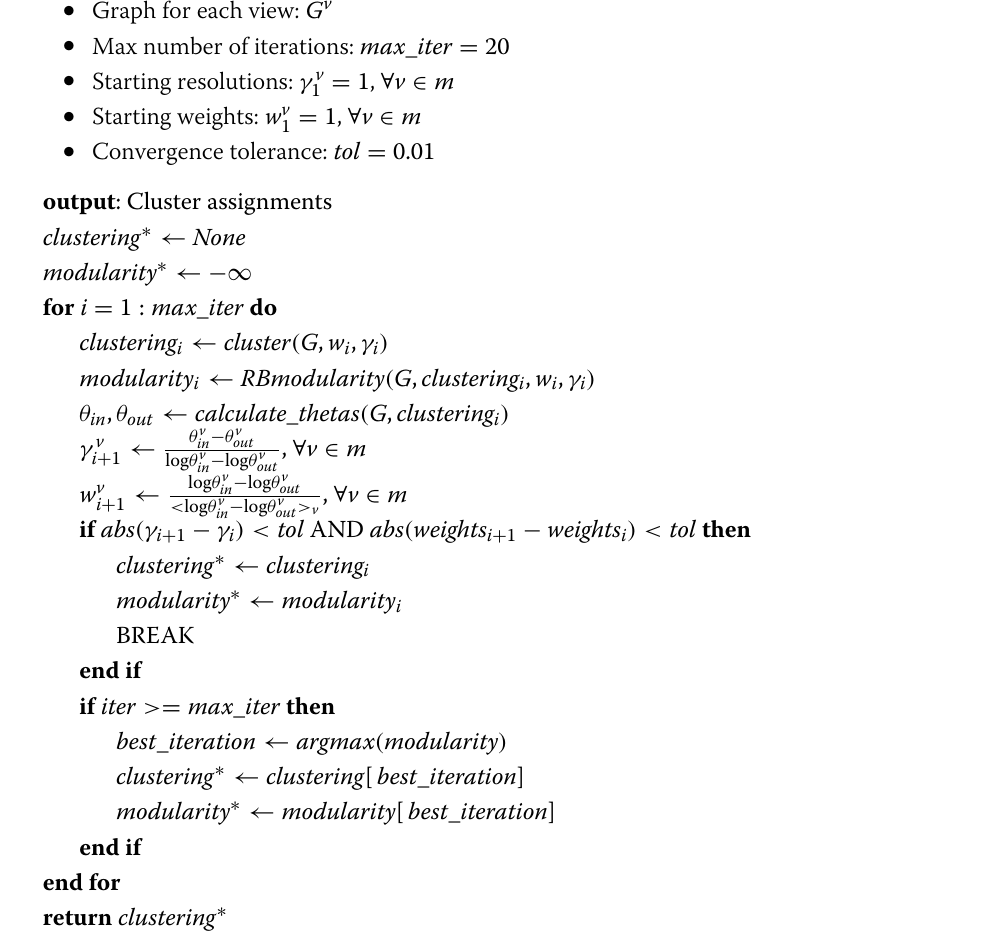
Algorithm 1 Multi-view Modularity Clustering